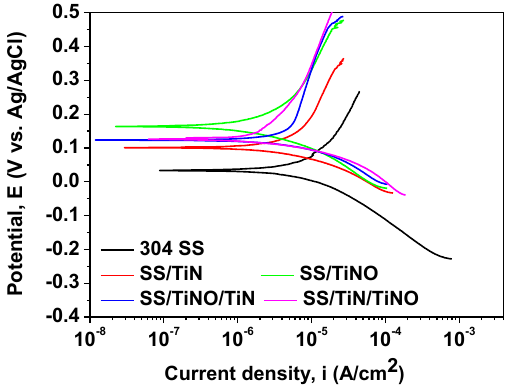
Figure 5. Potentiodynamic curves of studied samples in 0.10 M NaCl + 1.96 M H 2 O 2 at 37 ± 0.5 °C. Table 3. Corrosion parameters of studied samples in 0.10 M NaCl + 1.96 M H 2 O 2 at 37 ± 0.5 °C: E oc : open circuit potential; E corr : corrosion potential; i corr : corrosion current density; R p : polarization resistance; P: porosity; P e : protective efficiency.